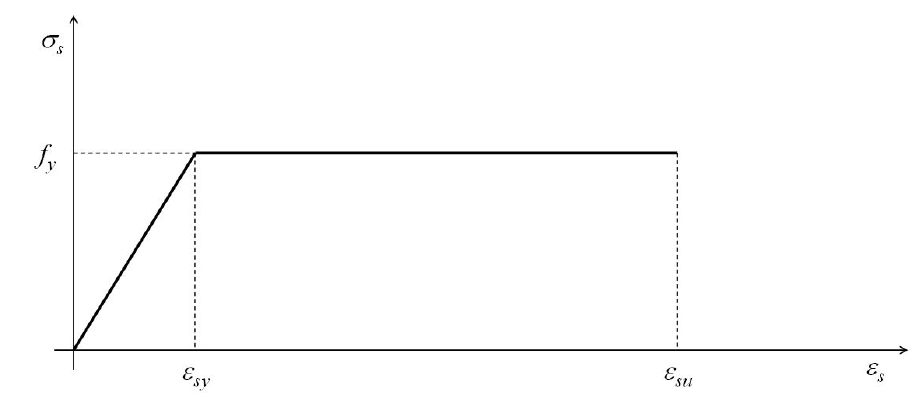
Figure 6. Simplified stress-strain diagram for longitudinal